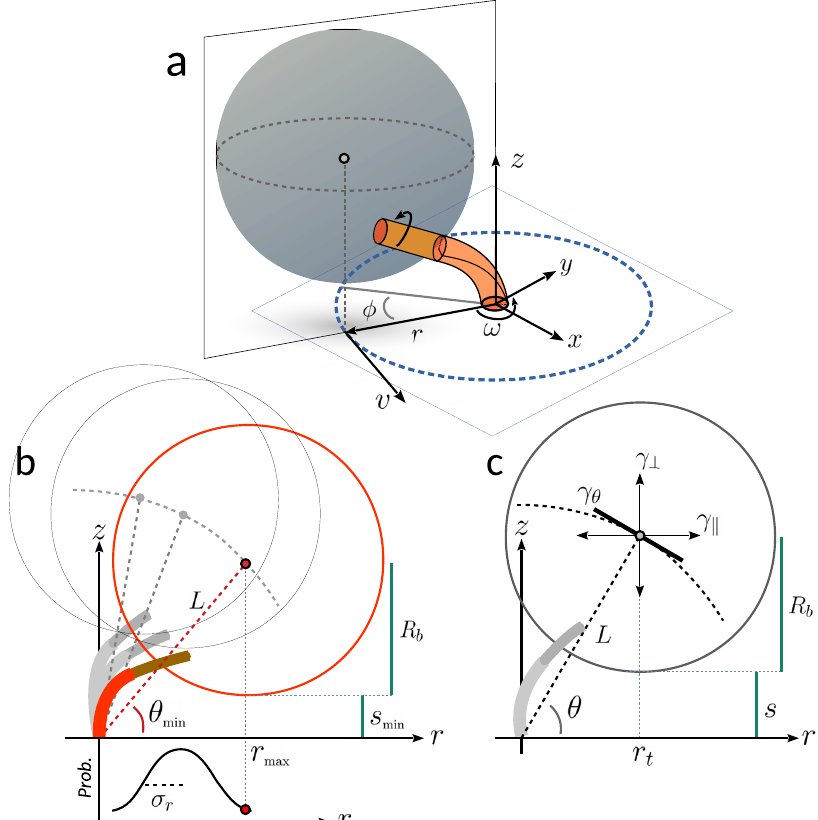
Fig. 2 Microscopic geometrical model. a 3D representation of the bead (not to scale) tethered to the fl agellar stub, composed by the hook (red, length of 60 nm) and fi lament (FliC st , orange, of 20-nm diameter 32 ). The angle ϕ describes the motion of the center of the bead along the circular trajectory of radius r . The linear speed of the bead is v = ω r , where the angular velocity is ω = d ϕ / dt . b Projection on the ( z , r ) plane, where the center of the bead is assumed to move on an arc of radius L , described by the angle θ . The probability distribution of r (approximated by a Gaussian of width σ r ) is shown in the graph below. The minimum value of θ visited in an entire measurement ( θ min ) corresponds to the maximum visited value of the radius r max , and to the minimum distance s min between the bead surface and the membrane. c Same as in b for a generic position ( r t , θ ) at time t . The drag coef fi cient on the plane ( z , r ) is composed by a parallel ( γ ∥ ) and perpendicular ( γ ⊥ ) component with respect to the membrane, which are projected ( γ θ ) on the direction tangent to the arc of radius L . The distance between the bead surface and the membrane is s ð t Þ (cid:2) s min . The radius of the bead is R b